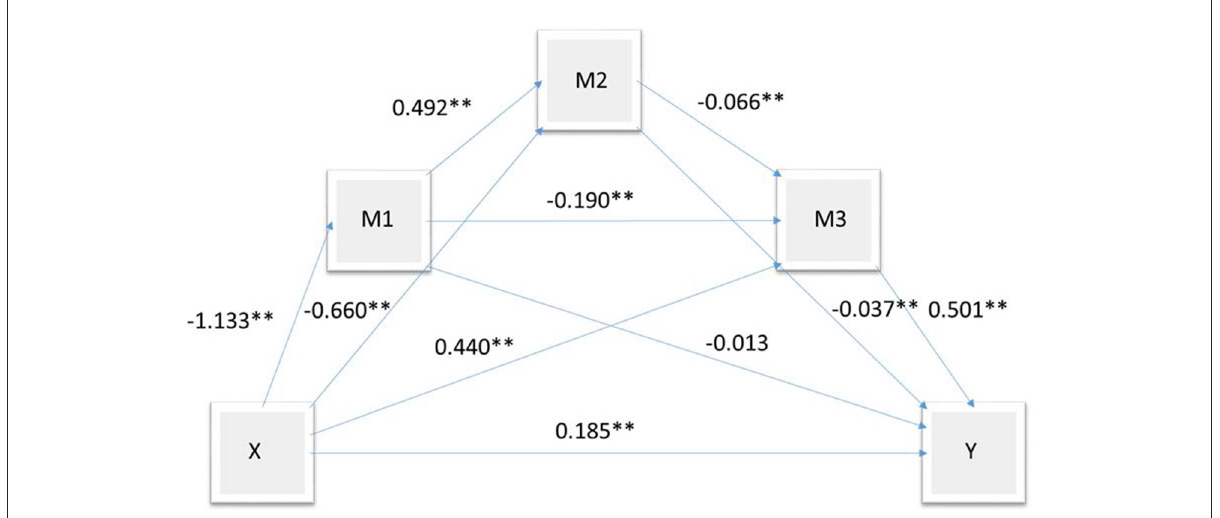
FIGURE2 Path map of psychological stress on MUS; Y indicates MUS; X, psychological stress; M1, resilience; M2, perceived social support; M3, depression. ** p <